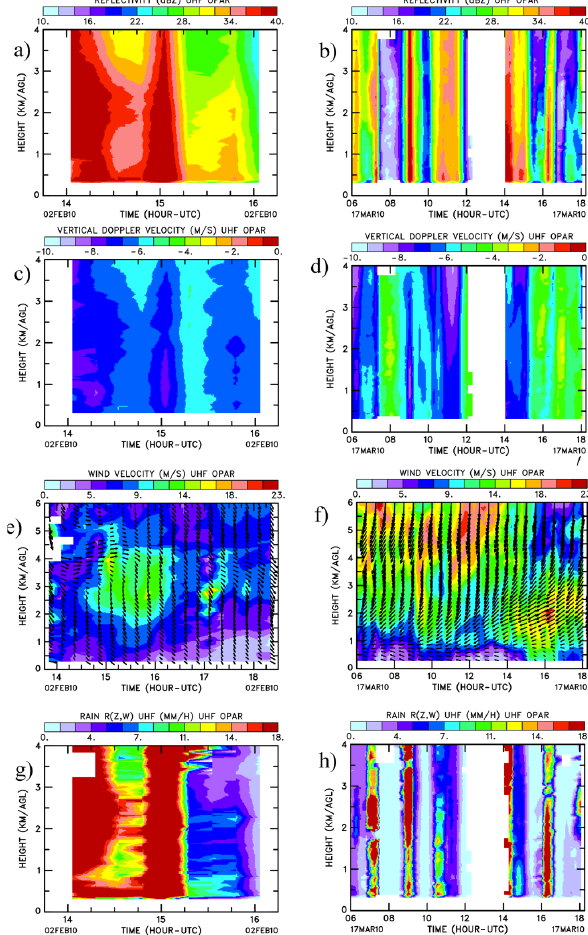
Fig. 8. As in Fig. 7 but for 2 February 2010 (left panel) and 17 March 2010 (right panel). variability, with values ranging from 10 to 40 dBZ, from − 3 to − 9 m s − 1 and from 2 to 23 m s − 1 , respectively. The verti- cal structure of the wind (Fig. 8f) indicates the presence of strong horizontal winds at all altitudes. A directional wind shear could be noticed with easterlies below 1 km progres- sively veering to northerly at 4 km a.m.s.l. In that case, the rain rate attains 18 mm h − 1 in short durations ( ∼ 15 min) and shows more variability with